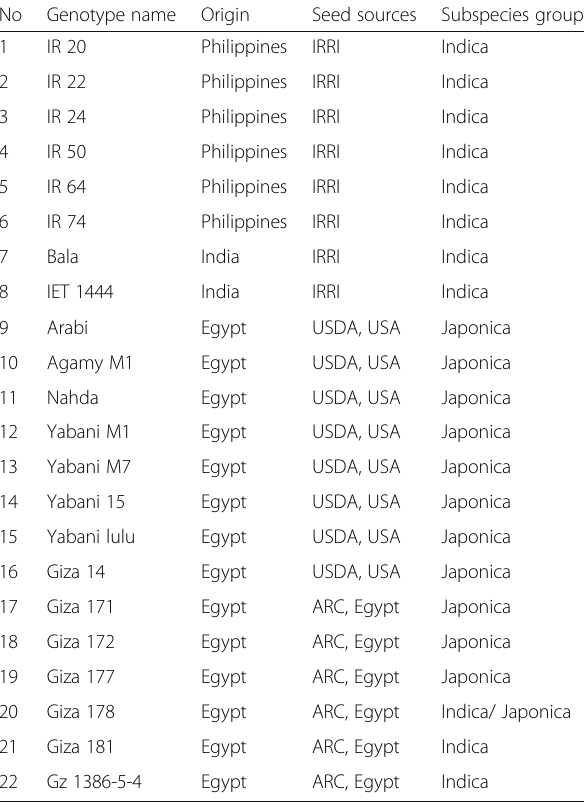
Table 1 Genotype names, origin, seed sources, and types of rice genotypes used in this